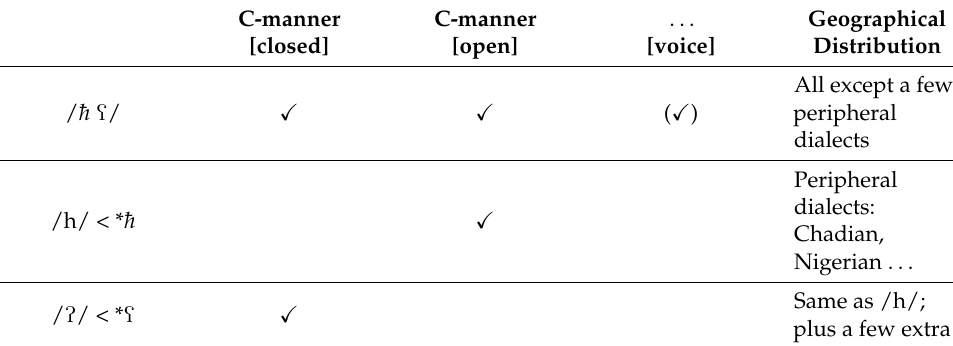
Table 7. Representational typology of *¯ h –* Q phoneme